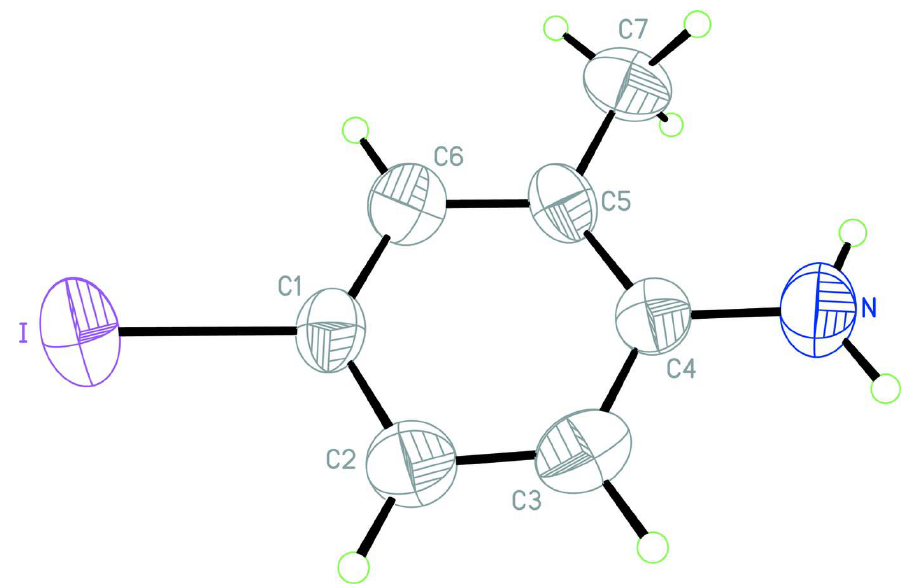
Figure 1 The molecular structure of the title molecule with the atom-numbering scheme. Displacement ellipsoids are drawn at the 50% probability